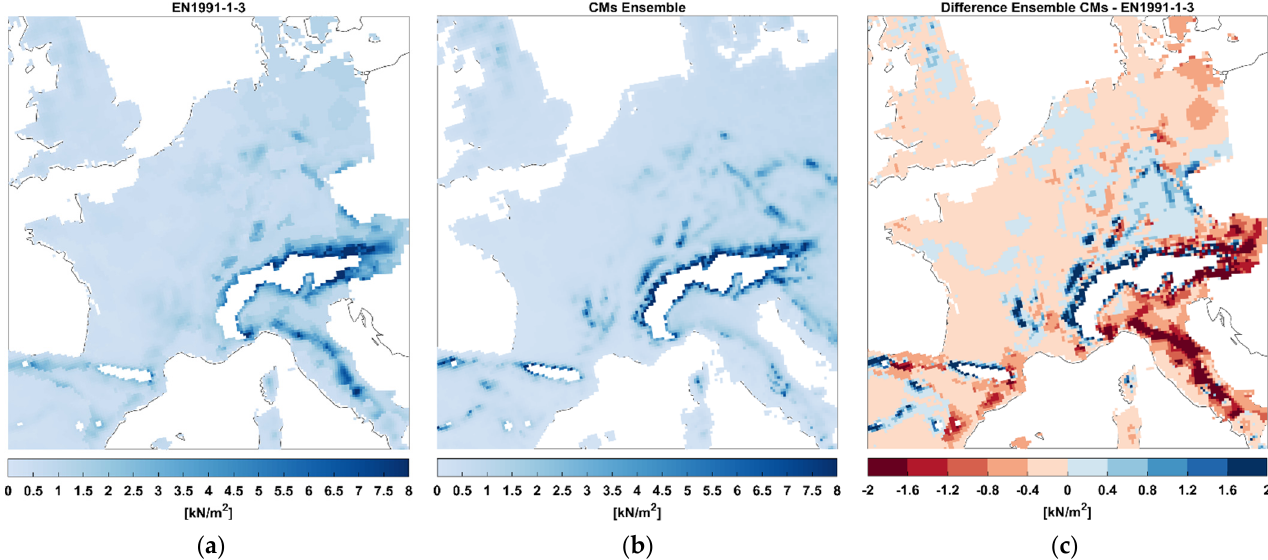
Figure 3. Characteristic ground snow load maps as provided in EN1991-1-3:2003 ( a ) and derived according to the Climate Models Ensemble mean ( b ), difference map between CMs ensemble and EN1991-1-3:2003 ( c ) for the period 1951–1990.